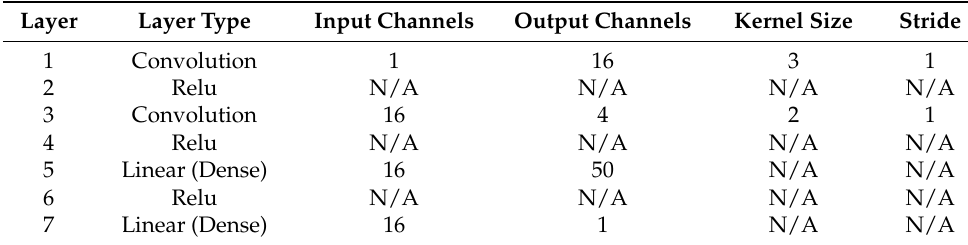
Table 3. The list of hyperparameters of the CNN-based model. Layer